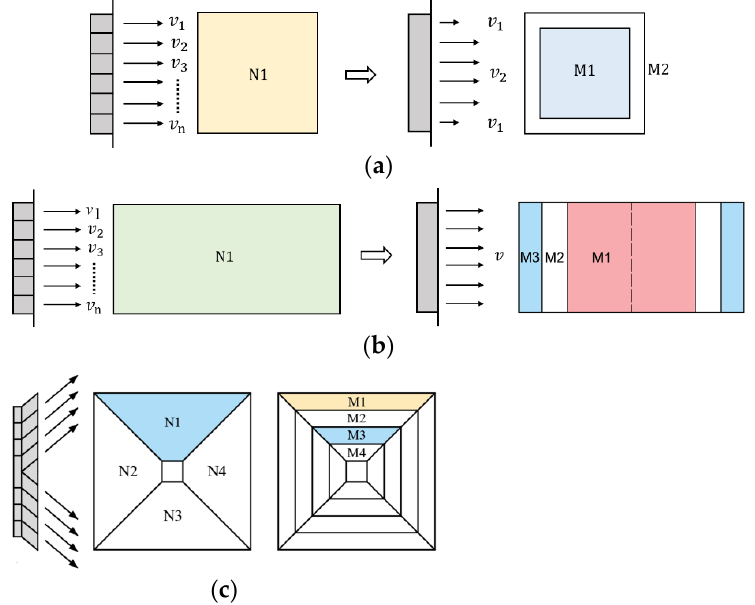
Figure 8. Diffuser velocity-inlet area division. Uniform velocity-inlet case on the left, non-uniform velocity-inlet case on the right. ( a ) Square grille diffuser. ( b ) Rectangle grille diffuser. ( c ) Square ceiling diffuser.